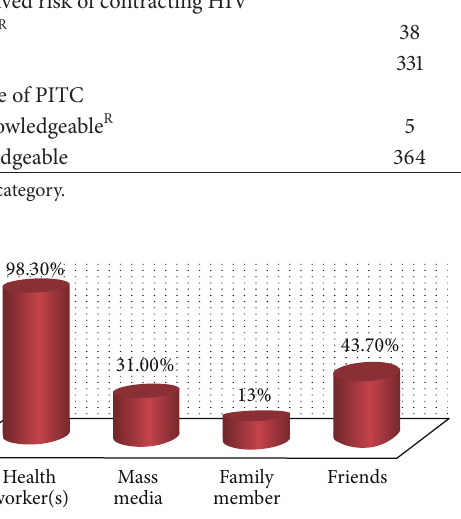
Figure 1: Source of information about PITC, among TB patients in East Wollega administrative zone at selected health centers, August